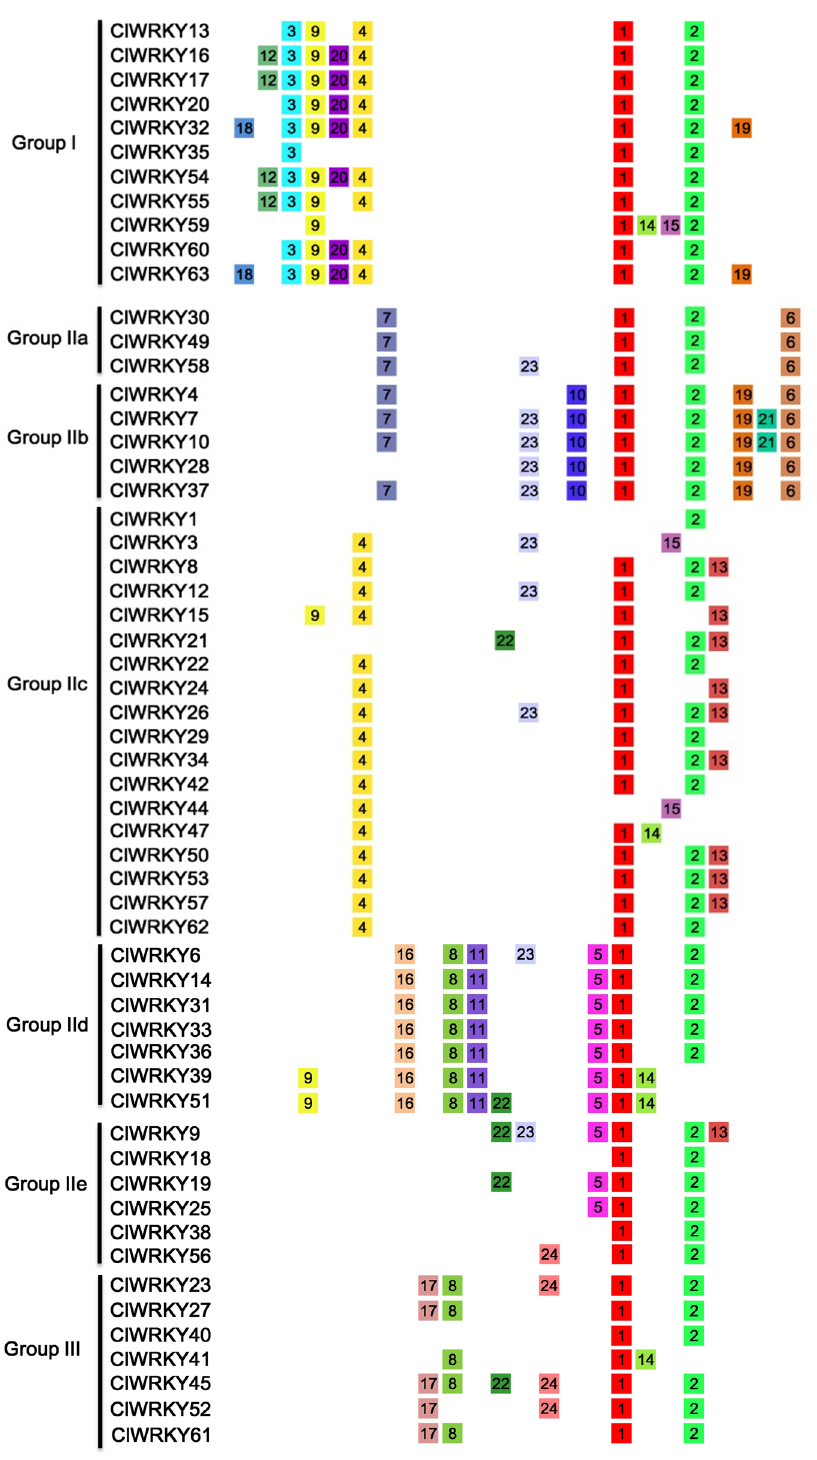
Fig 4. Schematic representation of 24 conserved motifs in watermelon WRKY proteins. Conserved motifs were named as motif 1 to motif 24, and different motif was shown as colored boxes with their names in the center of the boxes. The colored boxes were ordered manually according to the results of the MEME analysis. The length of each box in the figure does not represent the actual motif size.